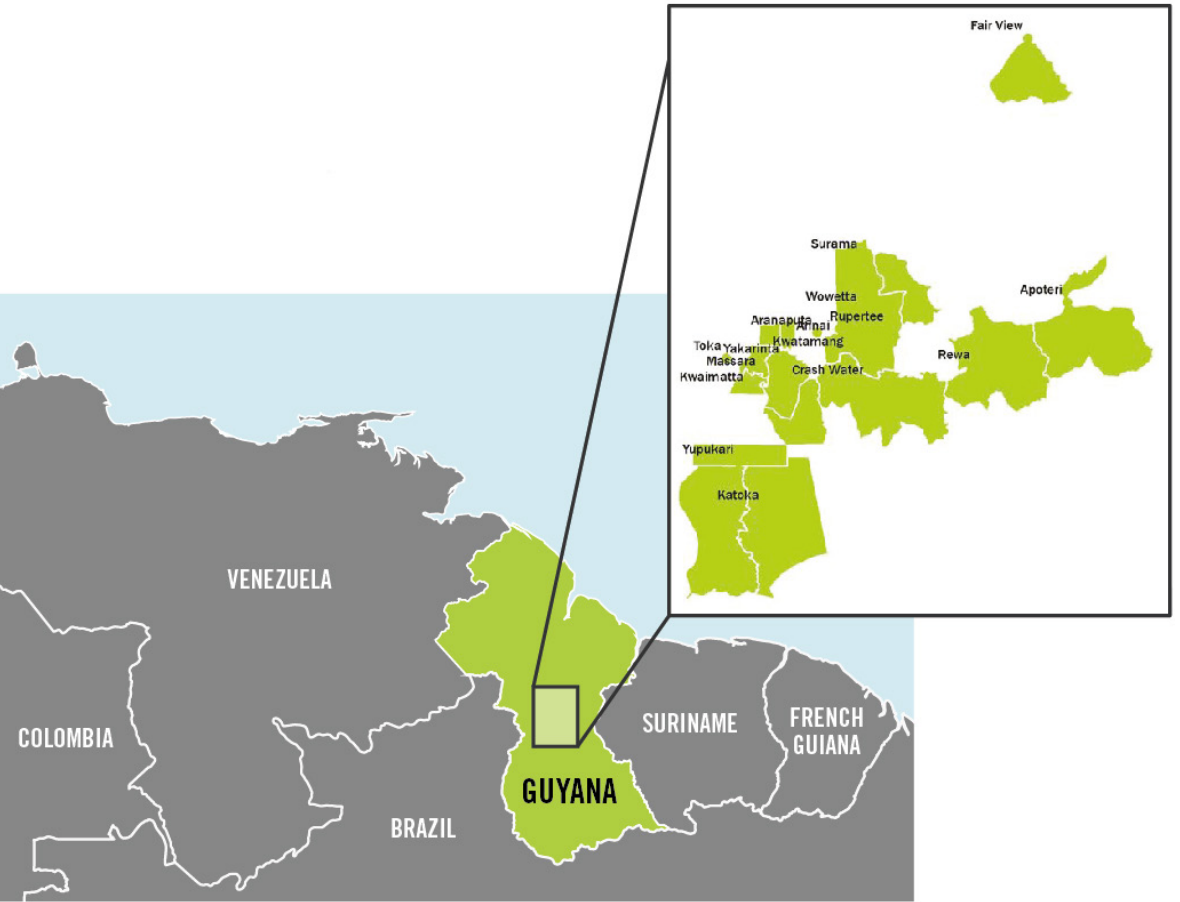
Figure 1. Map of the participating communities in the North Rupununi,